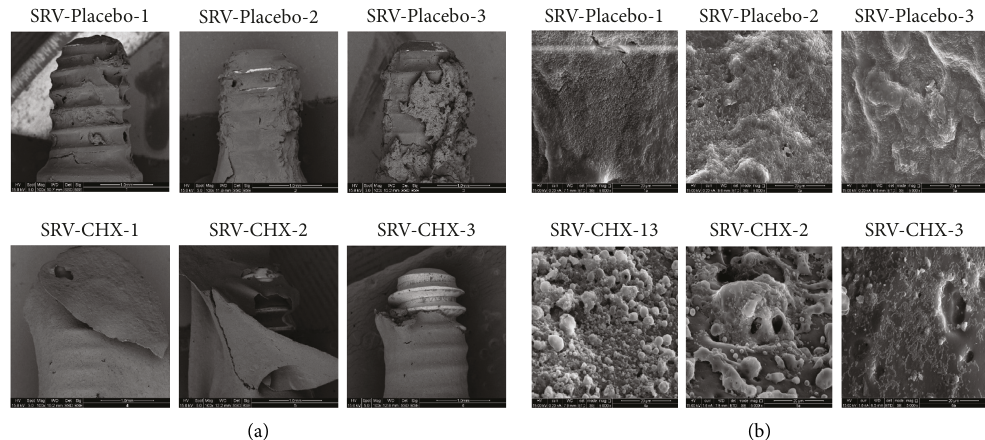
Figure 4: HR-SEM images of abutment-associated biofilm. The abutment-associated biofilms formed after 13 days of abutment exposure to S. mutans were visualized using HR-SEM. (a) Upper panel: SRV-placebo-coated abutments, 1, 2, and 3; lower panel: SRV-CHX-coated abutments, 1, 2, and 3. Magnification × 100. (b) Upper panel: SRV-placebo-coated abutments, 1, 2, and 3; lower panel: SRV-CHX-coated abutments, 1, 2, 3. Magnification ×